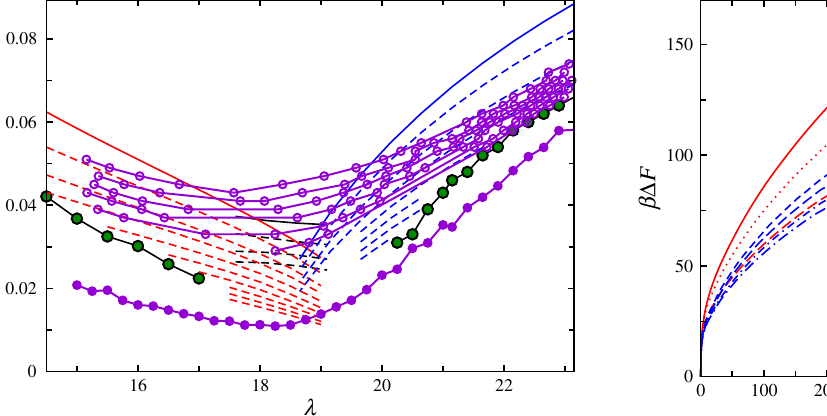
FIG. 9. Isodiffusivity lines for the SW model. The phase diagram is reproduced from Fig. 1(a), with superimposed iso- diffusivity lines (open purple symbols), and the glass line T 0 (full purple symbols) reproduced from the inset of Fig. 2(a). The isodiffusivity lines range from D ¼ 0 . 002 (slowest) to D ¼ 0 . 007 (fastest) with intervals of Δ D ¼ 0 . 001 .